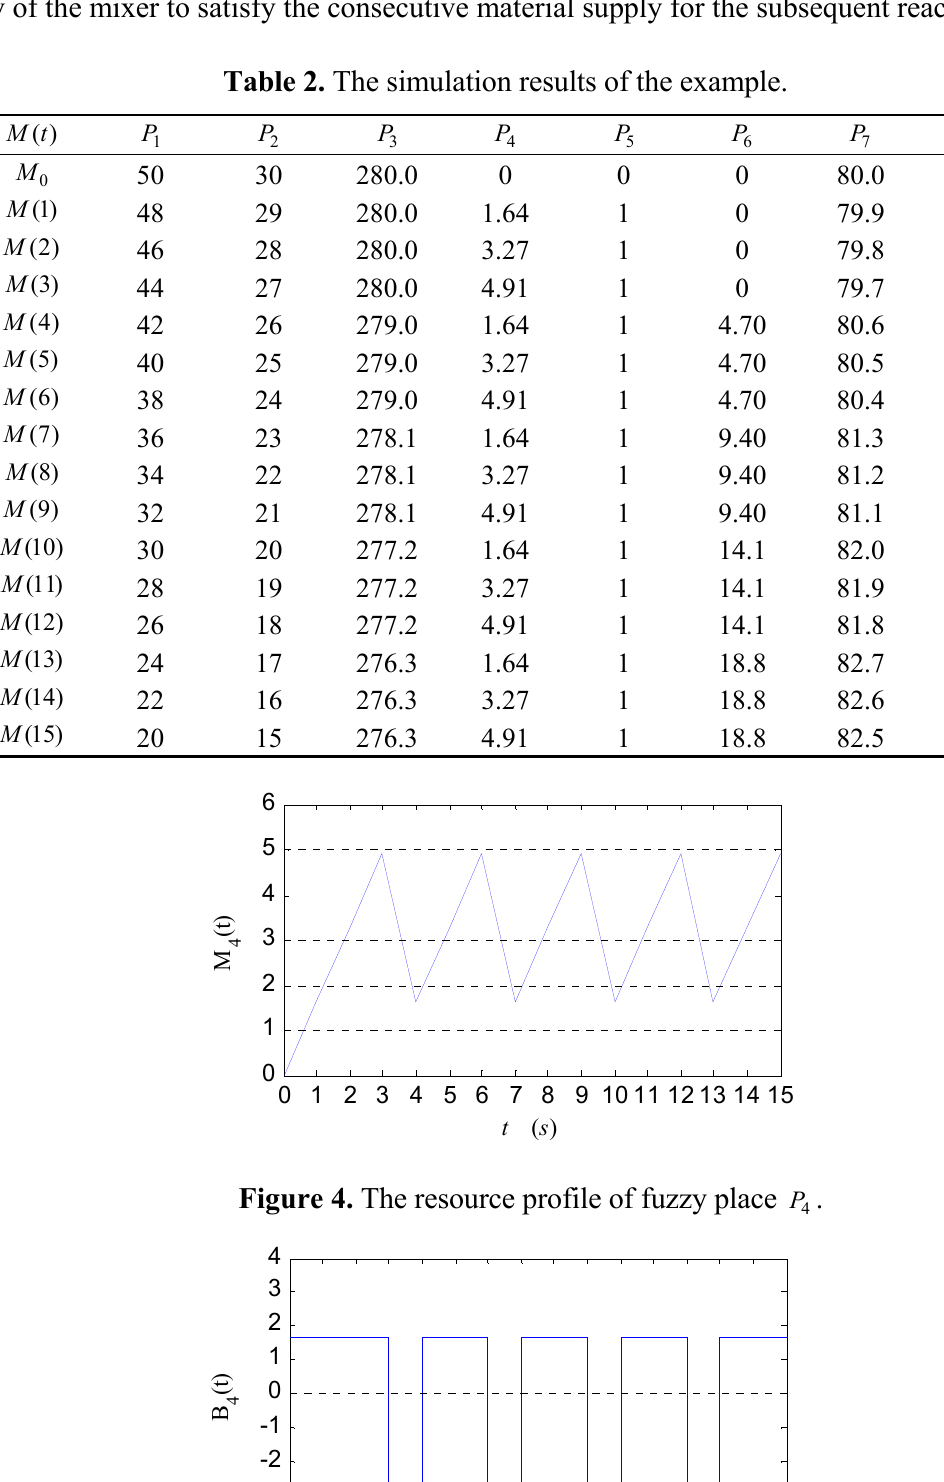
Table 2. The simulation results of the example.